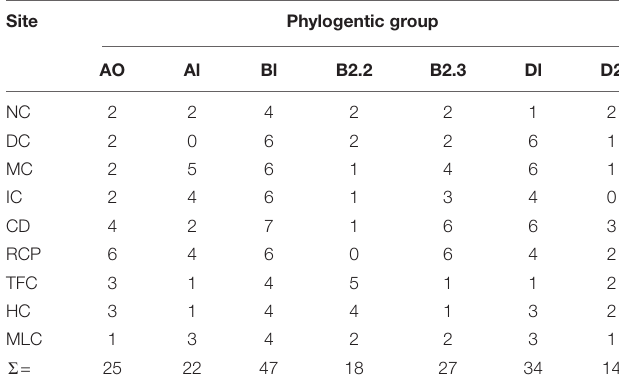
TABLE 2 | Phylogroups of E. coli isolates ( n = 187) from the irrigation return flows and background canal site